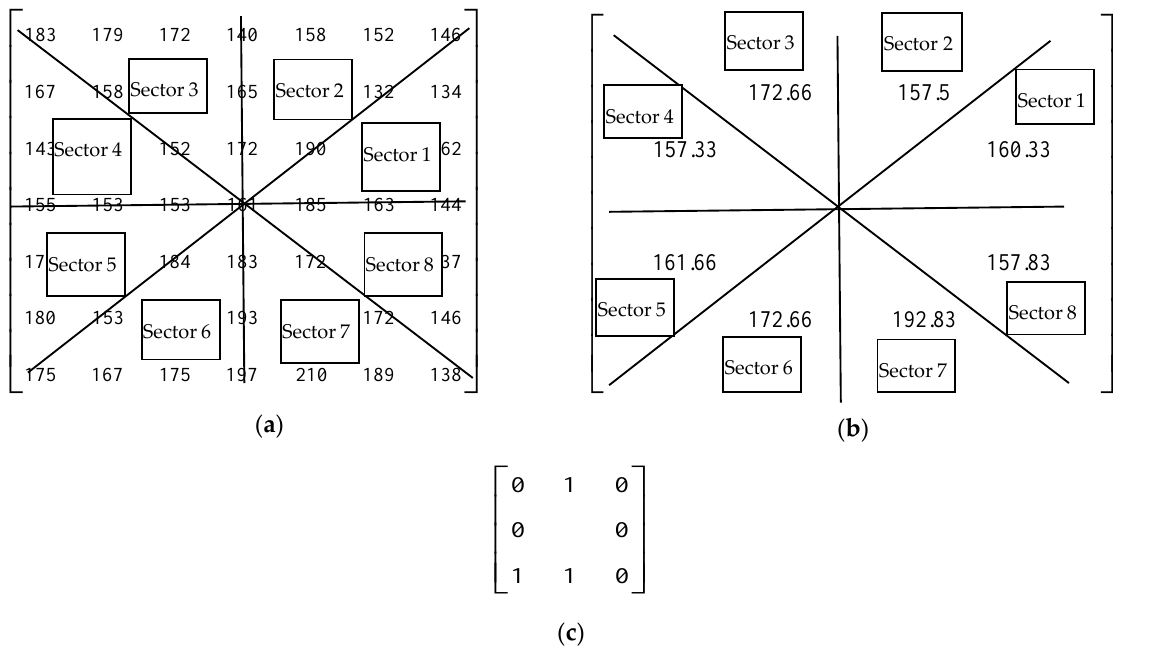
Figure 3. Steps detailed for the calculation of the proposed AvP-LBP descriptor for the center pixel in an example image patch. ( a ) Image Patch and sectors for R = 3, p = 8, and θ = 45 0 . ( b ) Average value of the circular sector = sum (185,163,144,190,132,146)/6 = 160.33. ( c ) AvN-LBP pattern is 01100100 for µ r = sum (160.33, 157.5, 172.66, 157.33, 161.66, 172.66, 192.83, 157.83)/8 =166.26 and AvN-LBP = 100.